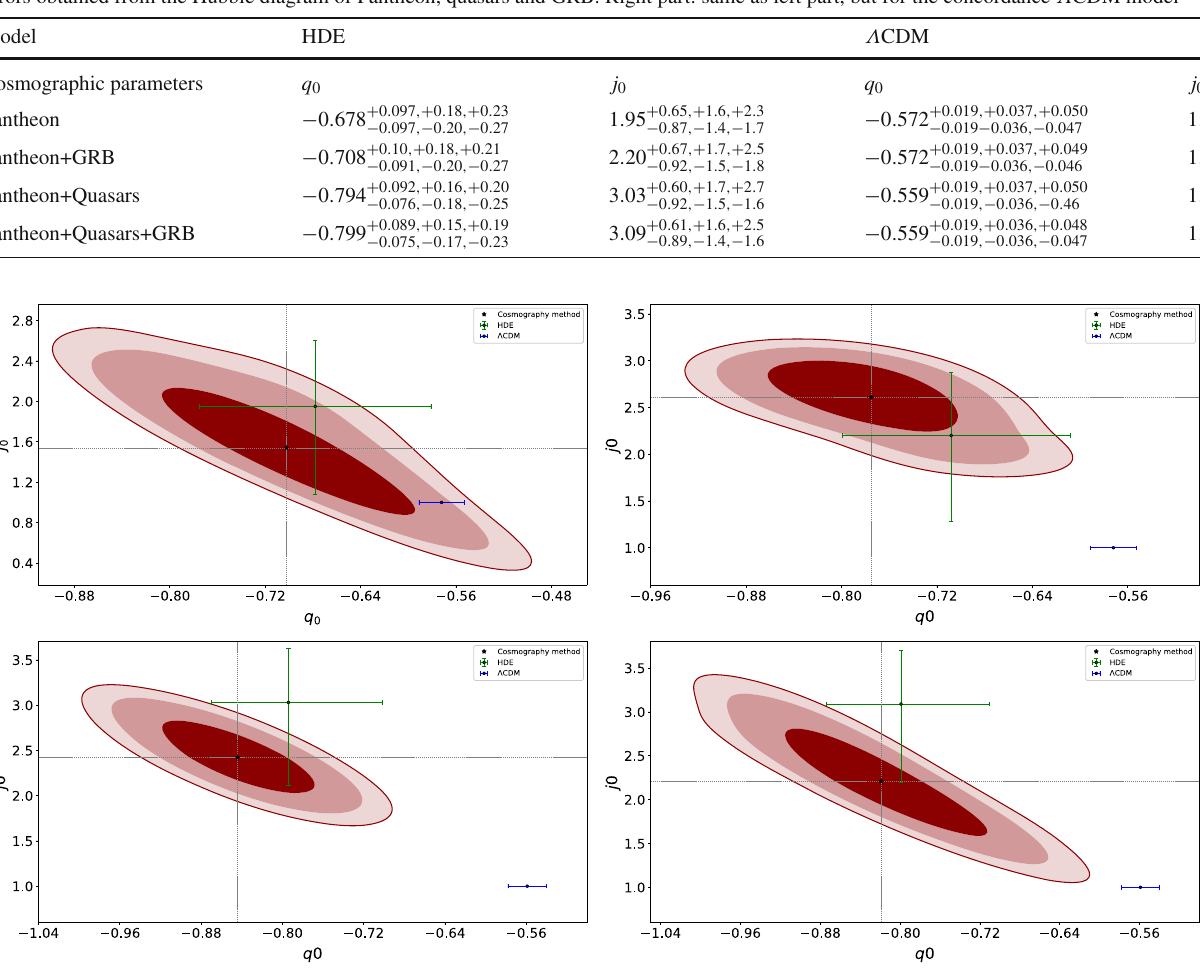
right) panel shows the results for Pantheon (Pantheon + GRB) sample. The bottom-left (lower-right) panel shows the results for Pantheon + Quasars (Pantheon + Quasars + GRB)